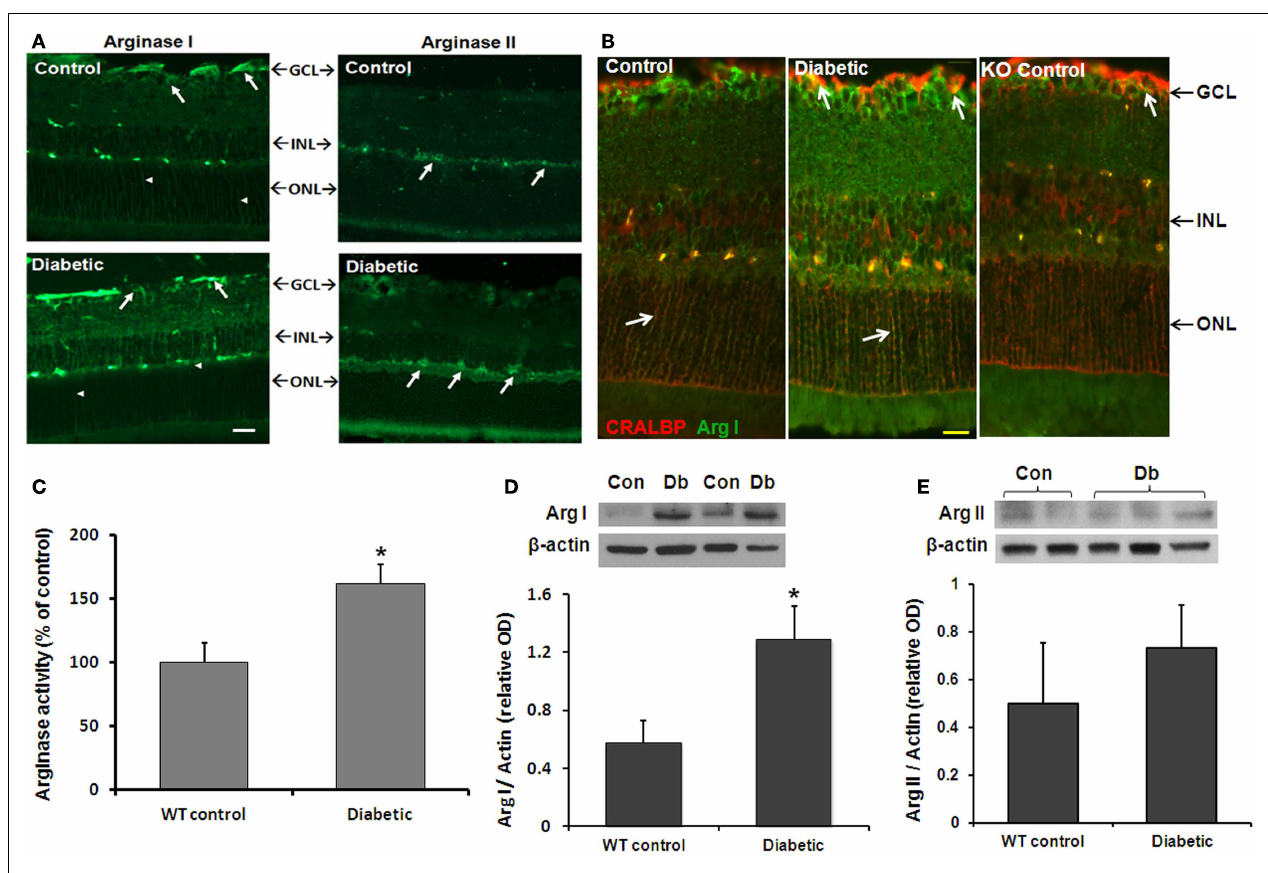
cells of the wild type and AI + / − AII − / − (KO) retinas. Scale bar = 20 µ M. (C) Arginase activity was determined using an assay for urea formation. Relative levels of arginase I (D) and arginase II (E) protein expression in retinal vascular cells were determined byWestern blot analysis of isolated retinal vessels ( n = 6–30) (* p < 0.05 compared with the non-diabetic control).